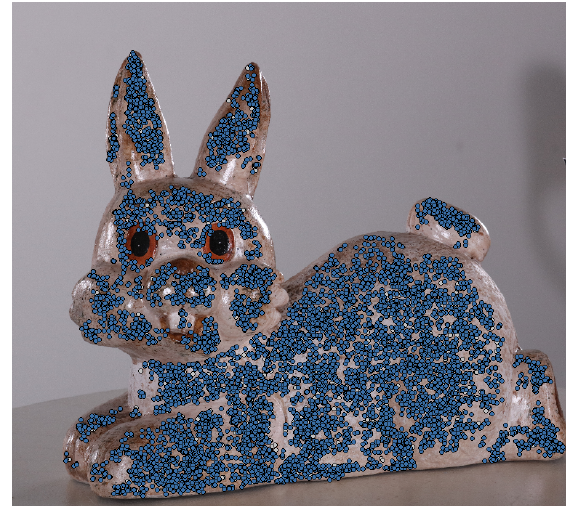
Figure 5. An image used as input to the SfM solution and calculated feature points. A radius is set around each of the features and all points that are in the area are projected to the reconstructed